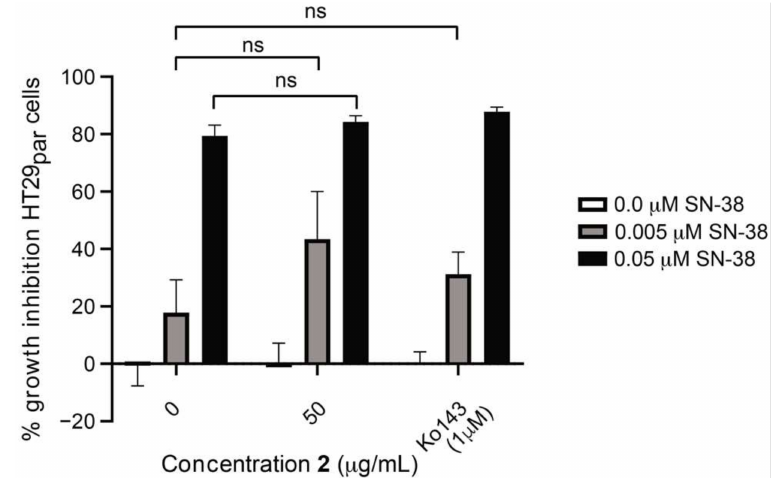
Figure 7. Percent cell-growth inhibition of HT29 par cells treated with 50 µ g/mL of compound 2 alone and in combination with 0.005 or 0.05 µ M SN-38. Ko143 (1 µ M) was used as a positive control. Error bars indicate SD determined on the basis of n = 4. ns = not statistically